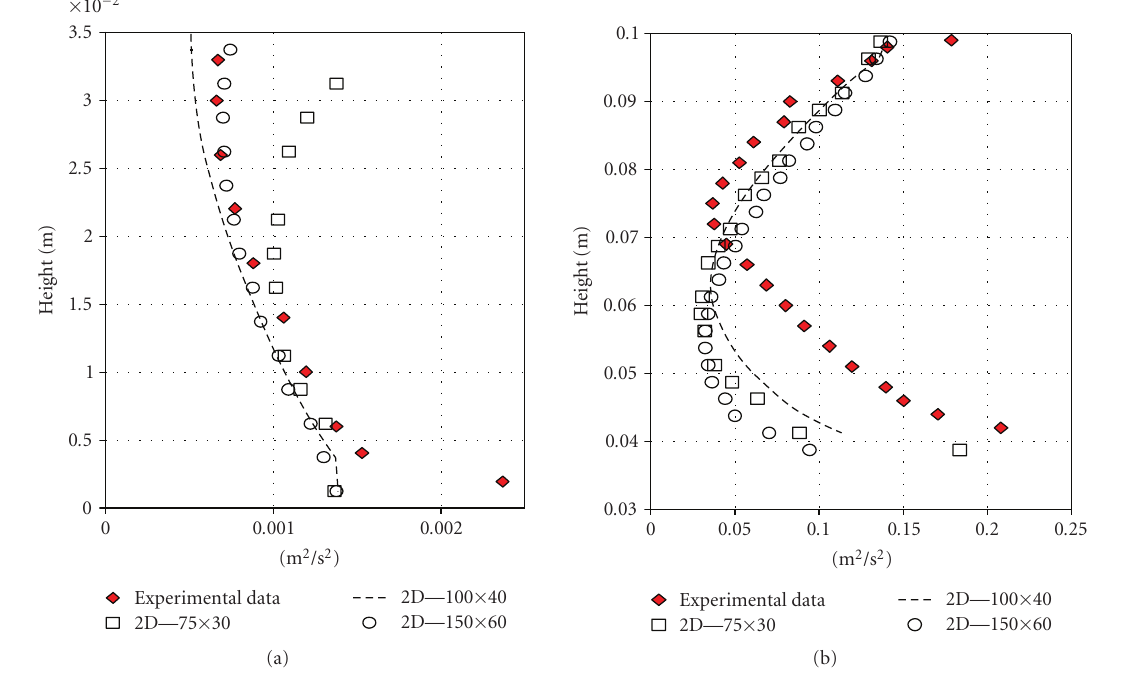
Figure 8: Turbulent kinetic energy: (a) water; (b)